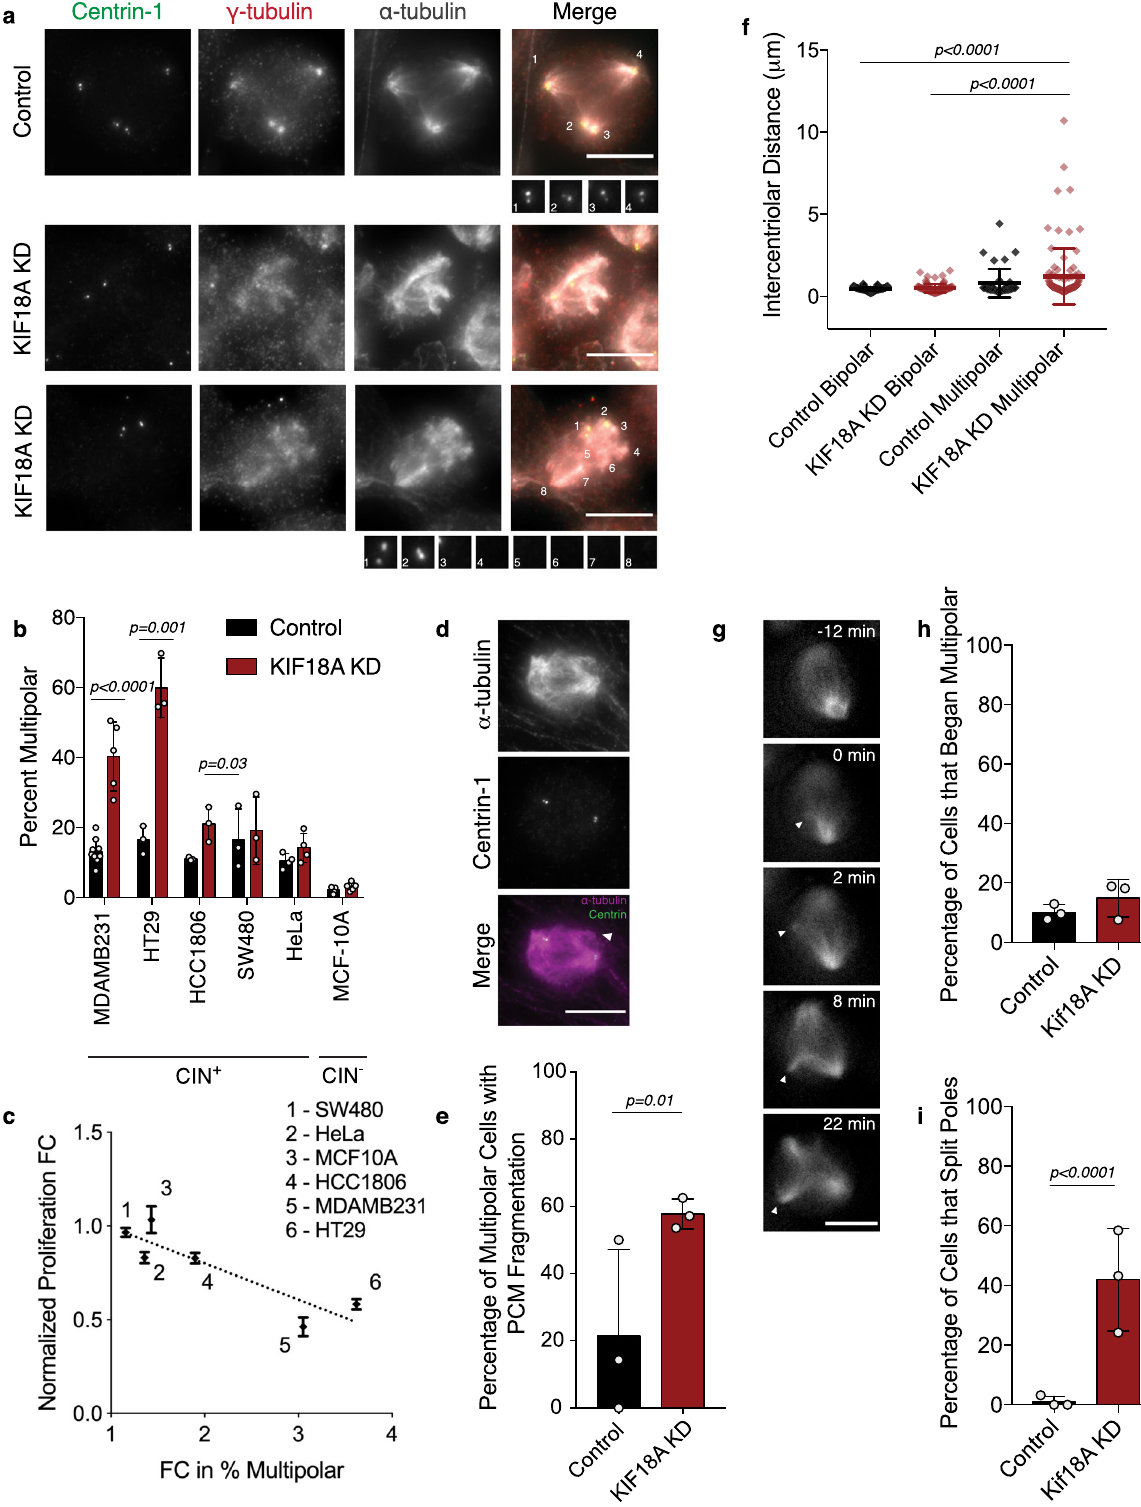
compared to KIF18A KD alone observed during live imaging may be explained by the limitations inherent to the identi fi cation of multipolar spindles in live assays, as poles must split suf fi ciently far apart to be completely separated in this case. Therefore, the live approach is likely to underestimate the actual time to splitting and percentage of multipolar spindles, especially in cells that exit mitosis quickly. Taken together, these data suggest that loss of